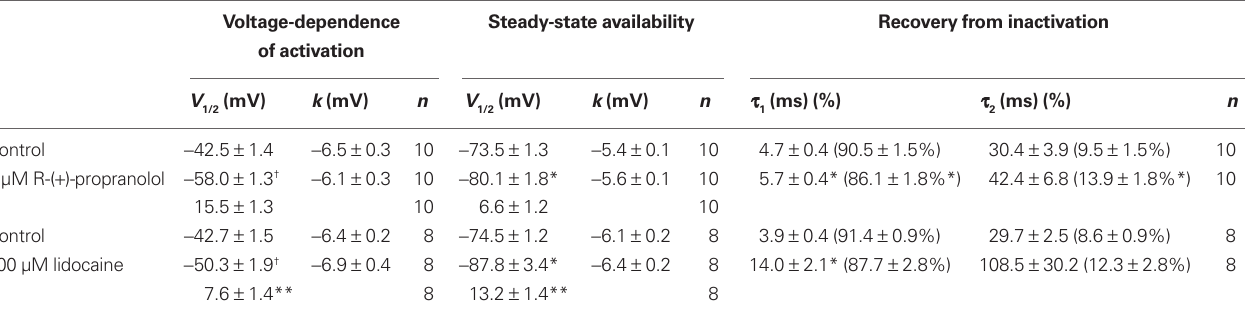
Table 2 | effects of r-( + )-propranolol and lidocaine on Na 1.5-F1760A biophysical properties. V Voltage-dependence Steady-state availability recovery from